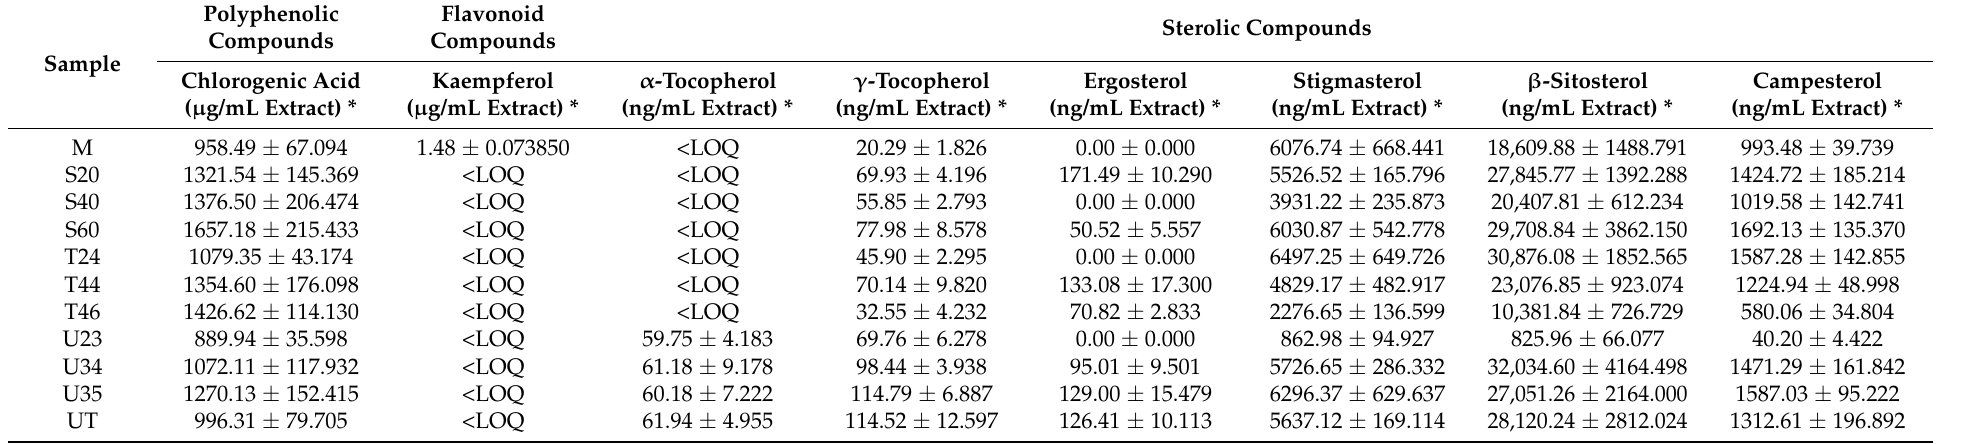
Table 4. Bioactive compounds in the selected green coffee bean extracts (concentrations of polyphenolic and flavonoid compounds were expressed as µ g/mL extract, concentrations of sterolic compounds were expressed as ng/mL